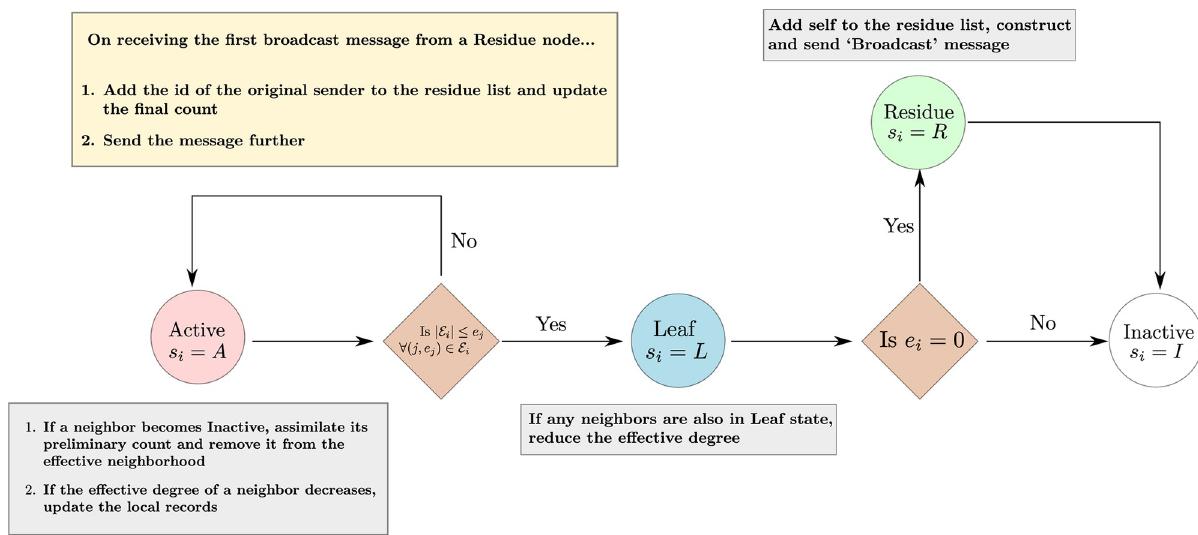
Fig 1. Schematic flowchart depicting the finite state machine of each node of the network executing the AnB algorithm. Note that the colors of the circles correspond to the colors of the section in Algorithm An overview of the AnB algorithm. Also, the steps outlined in the yellow box are carried out by all nodes irrespective of their